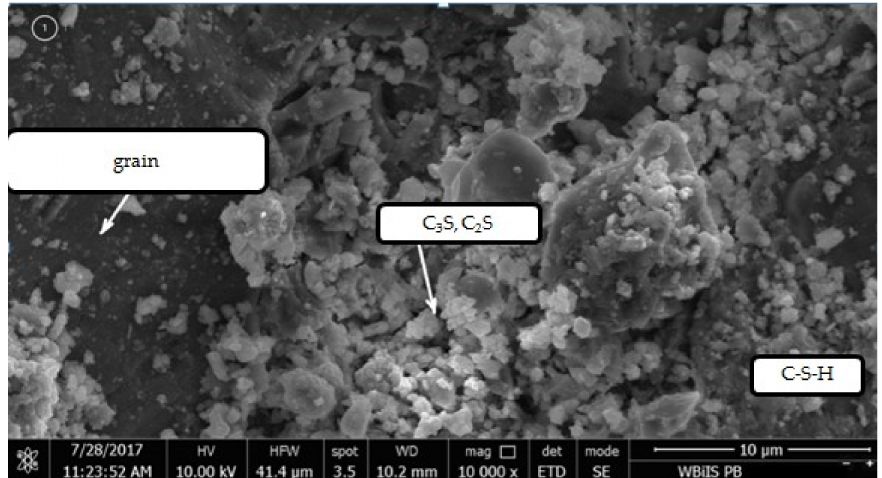
Figure 22. Recycled aggregate after thermo-mechanical